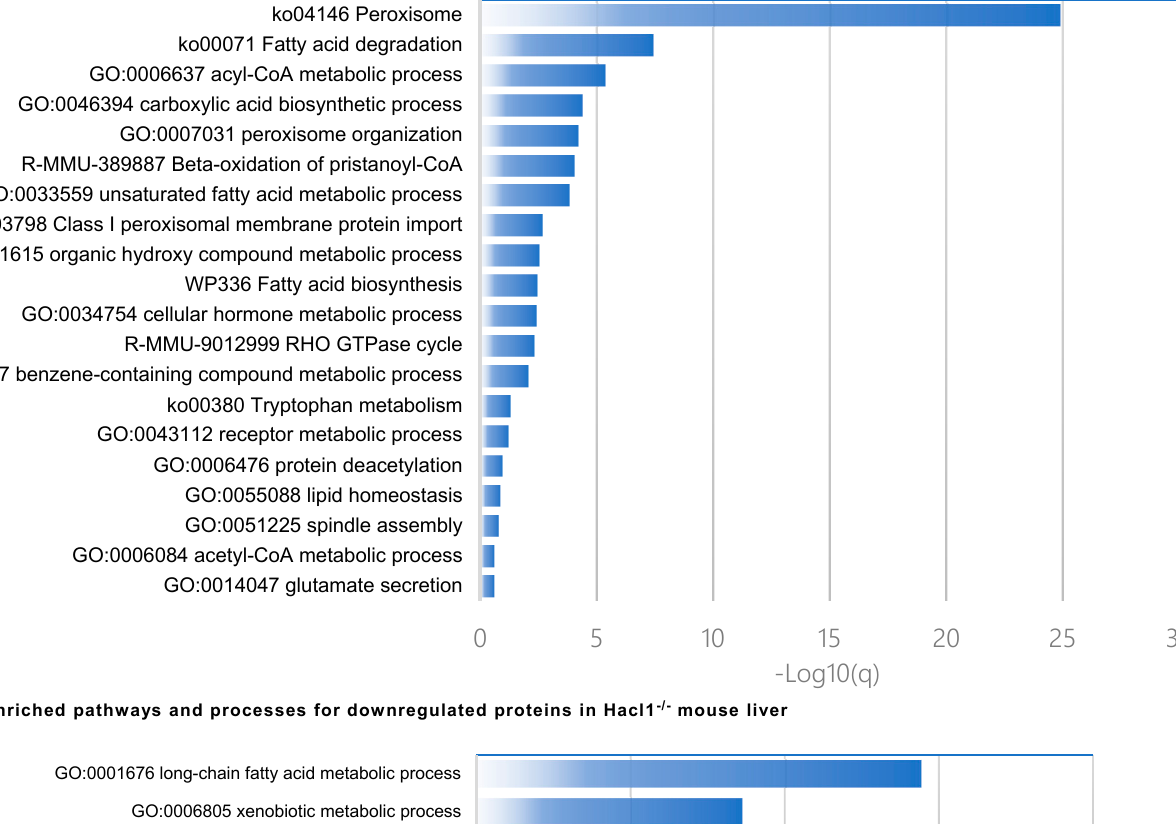
8 of 15 Figure 3. Proteomic analysis of Hacl1 − / − mouse tissue. ( A ) Scatter plot of proteins identified and their